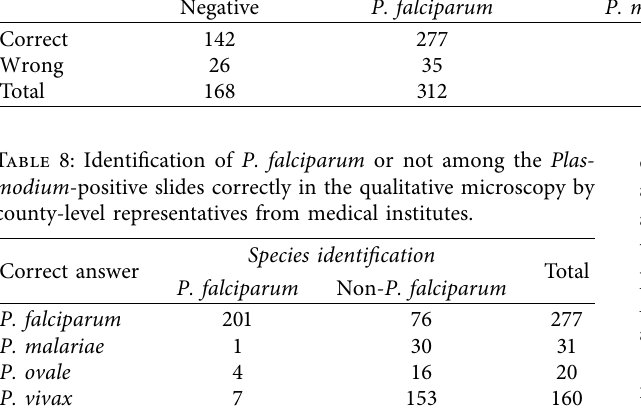
Table 7: Qualitative identification based on malaria microscopy by county-level representatives from medical institutes. Results